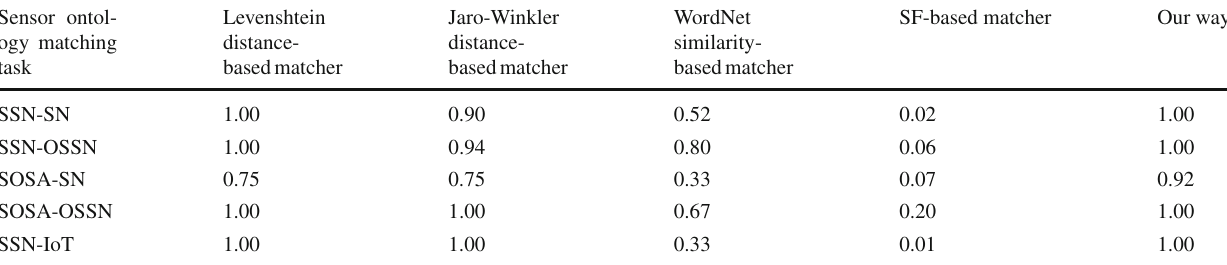
Table 21 Comparison on the proposed method and other classical matchers in terms of precision on sensor ontology test cases Sensor ontol- ogy